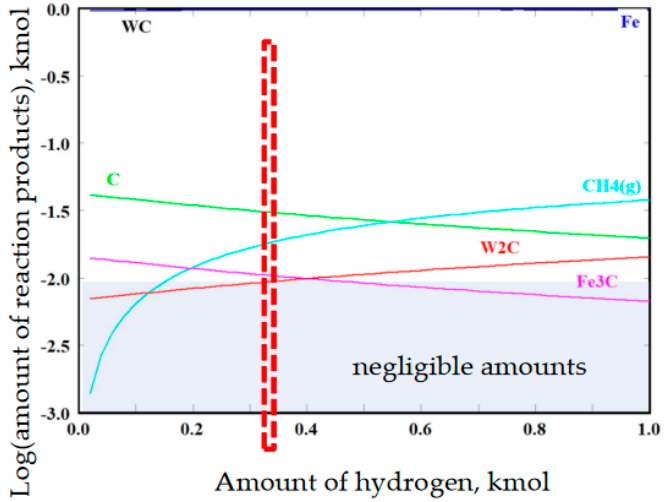
Figure 21. Reaction products in WC + 5% C + Fe system modeled in dry hydrogen atmospheres at 500 °C as a function of the amount of hydrogen in the system (reprinted with permission from Ref. [27], 2022, Elsevier). Vertical frame indicates the approximate amount of gas producing transfer layers with the experimentally detected